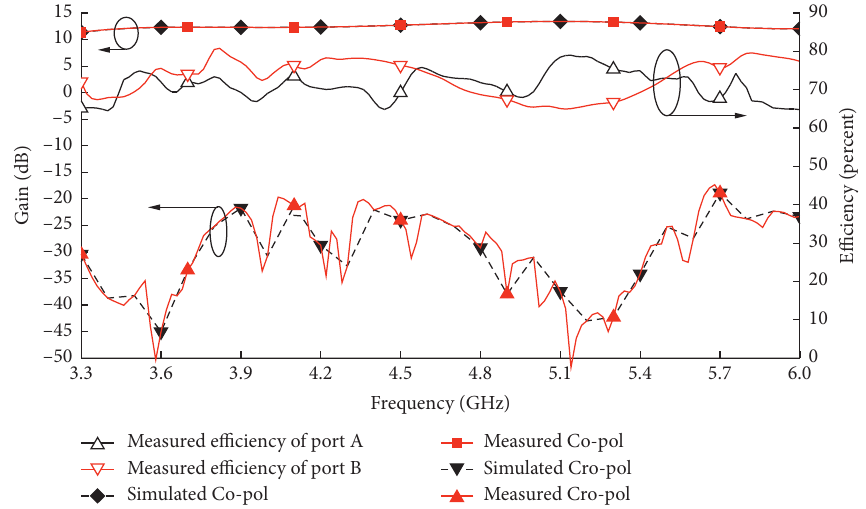
Figure 16: Simulated and measured gain and efficiency of the antenna array.